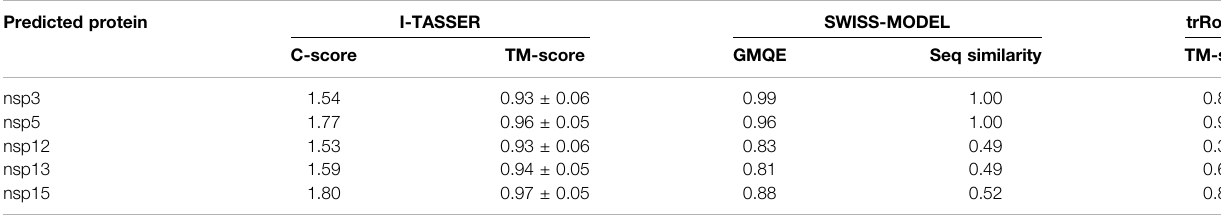
TABLE 1A | Targets were modeled by using three methods.